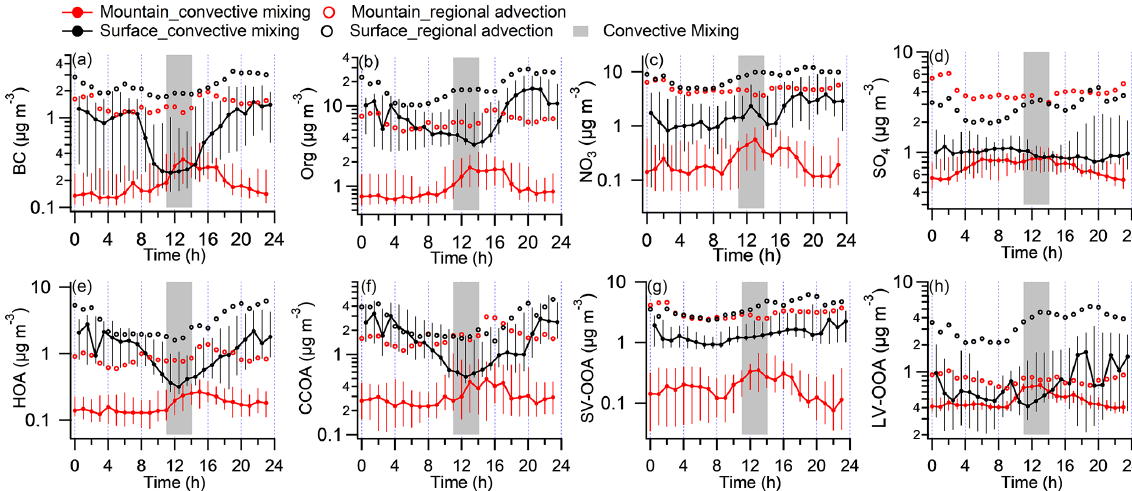
Figure 2. Diurnal variations in key aerosol compositions at both sites during convective mixing (CM) and regional advection (RA) periods. (a) Black carbon (BC). (b) Organics (Org). (c) Nitrate (NO 3 ). (d) Sulfate (SO 4 ). (e) The sum of hydrocarbon OA (HOA) and cooking- related OA (COA). (f) Coal-combustion-related OA (CCOA). (g) Semivolatile oxygenated OA (SV-OOA). (h) Low-volatile oxygenated OA (LV-OOA). The black and red colors represent the surface and mountain site, respectively. Solid circles and error bars show the median, 75th, and 25th percentiles in the CM period. Circle markers show the mean value in RA period. The gray bar represents the time of the day (11:00–14:00) with the most developed PBL.